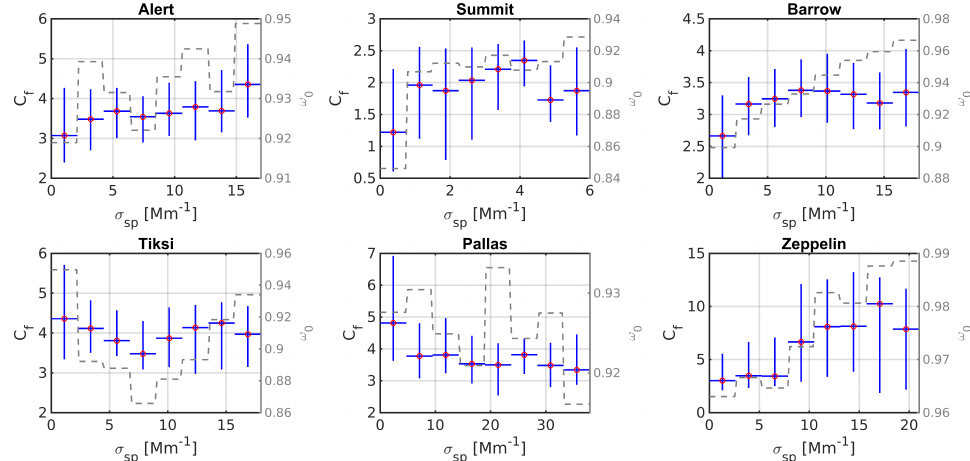
Figure 9. Aethalometer correction factor C f as a function of light scattering coefficients ( σ sp ) . The right hand y axis shows the median single- scattering albedo ( ω 0 ) of the aerosol calculated using σ ap from co-located light absorption photometers. The vertical whiskers represent the interquartile range (25th to 75th percentile range) with the median shown as a red circle. The C f , σ sp , and ω 0 values are at a wavelength of 637nm for all stations, except for Zeppelin (525nm).